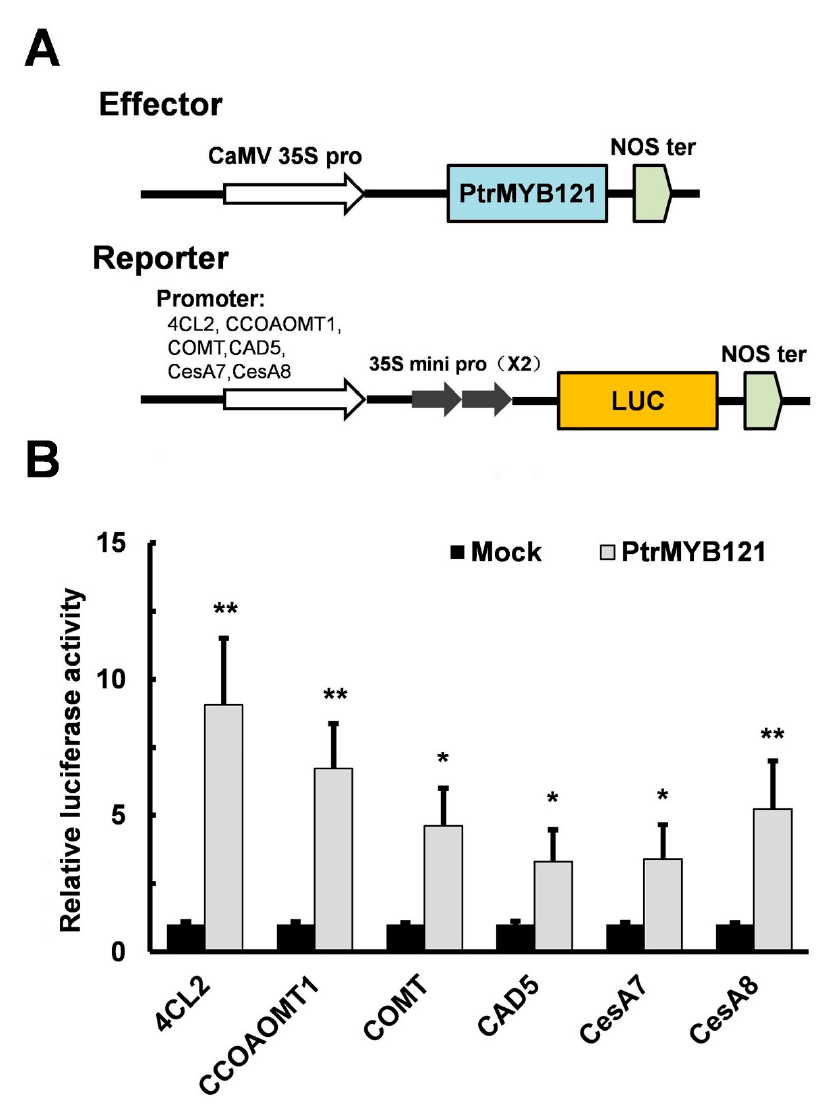
Figure 7. PtrMYB121 activates the expression of lignin and cellulose biosynthetic genes. ( A ) Pattern diagrams of the construction vectors in the effector-reporter system for transient activation analysis. The effector is the coding sequence (CDS) of PtrMYB121 driven by a 35S promoter. The reporters contain the luciferase (LUC) reporter gene driven by the 6 individual promoters of Arabidopsis 4CL2 , CCoAOMT1 , COMT , CAD5 , CesA7, and CesA8 genes, respectively; ( B ) Transient activation analysis shows that PtrMYB121 can promote the expression of reporters. All these effectors were individually transformed into the leaves of N. benthamiana as the mock treatments, and the relative expression of their LUC activity was set to 1. Error bars represent ± SD from three biological repeats. Student’s t-test: * p < 0.05 and ** p < 0.01.